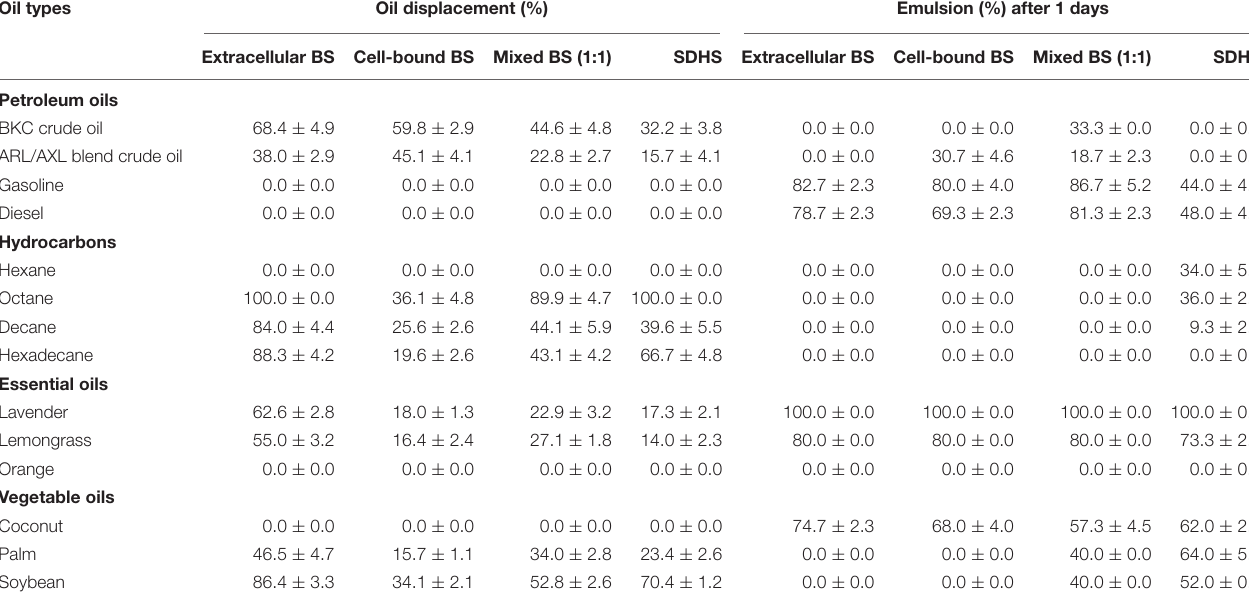
TABLE 2 | Oil displacement and emulsifying activities of crude extracellular, cell-bound, mixed biosurfactants (4xCMC), and synthetic surfactant (SDHS) on various oils. Oil